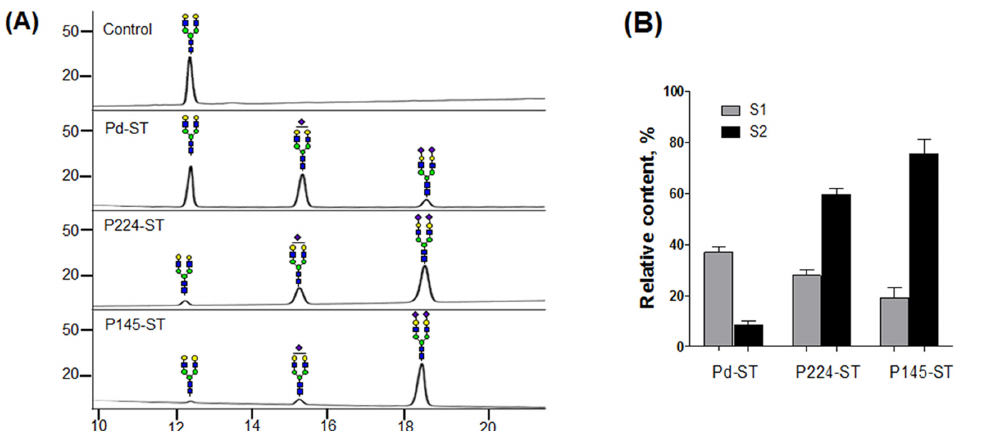
Fig 2. ST activity assays of bacterial α (2,6)-STs using G2 glycan as an accepting substrate. (A) The conversion of AA-labeled G2 glycan to sialylated glycans by Pd-, P224-, and P145-STs was analyzed by HPLC. The peaks of mono-sialylated (S1) and di-sialylated glycans (S2) as well as G2 glycan are indicated by symbol representation suggested by the Consortium for Functional Glycomics (http://www.functionalglycomics.org/). Blue square: GlcNAc, green circle: mannose, yellow circle: galactose, purple diamond: sialic acid. (B) Relative contents (%) of S1 (gray bar) and S2 glycan (black bar) were obtained by the calculation of integrated peak areas (100 × [The areas of corresponding glycan peaks]/[Total areas of all identified peaks]).